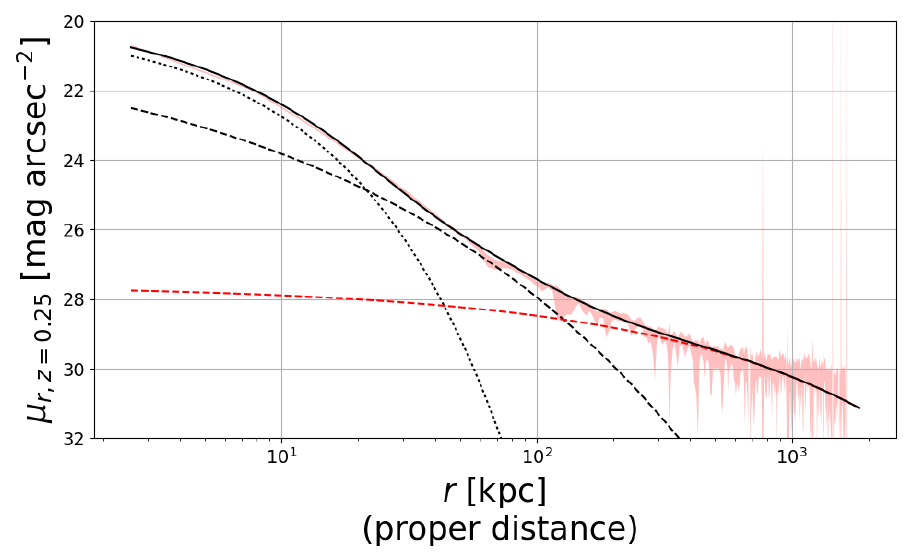
Figure 3. The BCG + ICL light profile from Zhang et al. [10] resulted from the stacking of around 300 clusters at redshift 0.2 < z < 0.3. The authors found that it can be approximated with three Sersic components (black solid line): a core (dotted line), a bulge (dashed line) and diffuse (red dashed line) components. See text for further details. Credit: Zhang et al. [10].